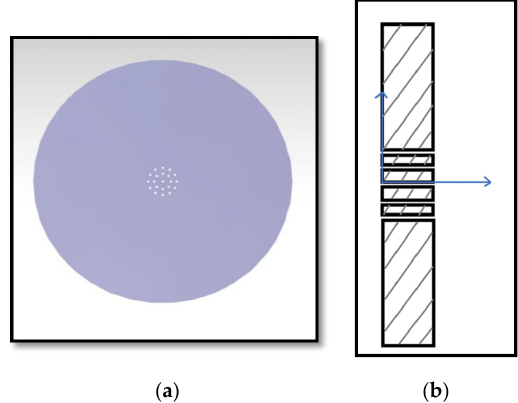
Figure 3. Catia V5 model of ( a ) shower head injector, ( b ) Exploded sectional view of shower head injector.